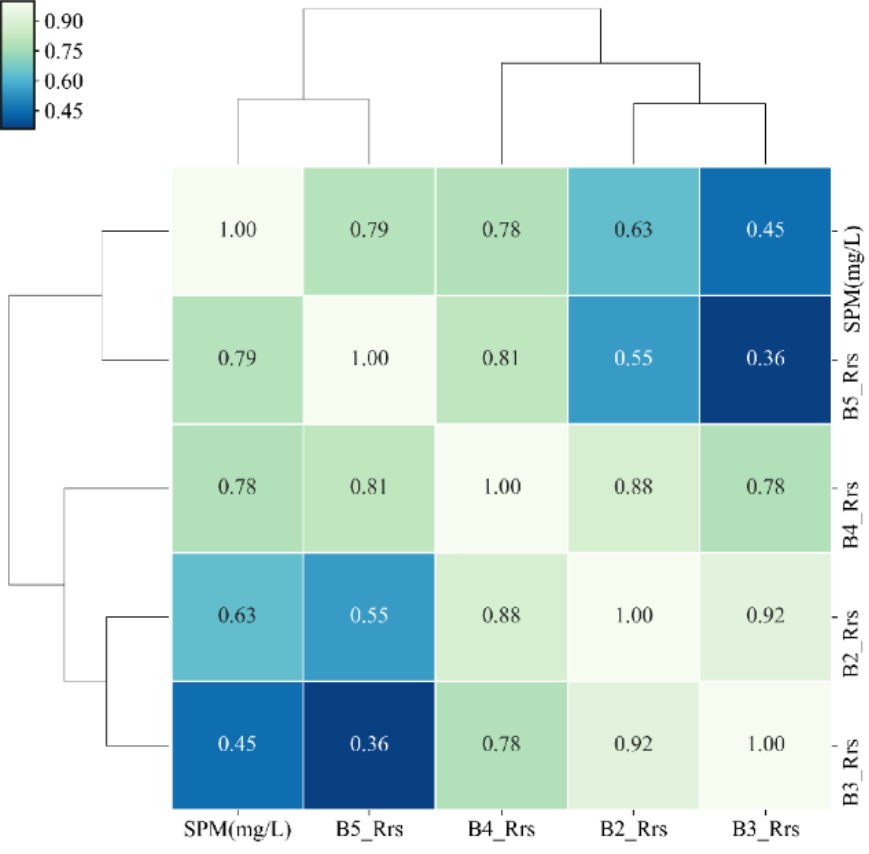
Figure 6. Schematic diagram of the correlations between the sensitive bands of the Landsat 8 B2–B5 reflectance data. Table 4. Evaluation of the accuracy by PLS, SVM, and RF inversion